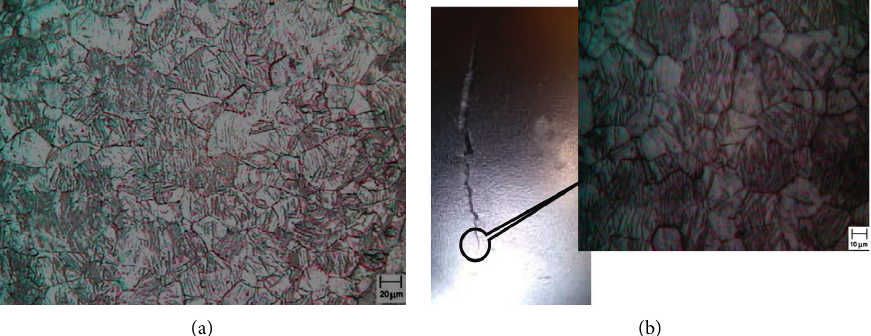
Figure 6: Microstructural changes in CP-Ti sample before and after deformation. (a) Original microstructure. (b) Deformed